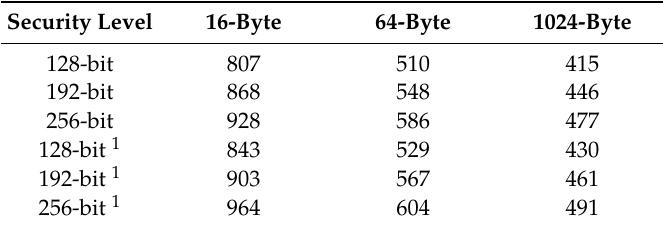
Table 4. Performance of AES–GCM evaluated by byte length for 16-byte, 64-byte, and 1024-byte messages (clock cycles per byte). 1 : register optimized